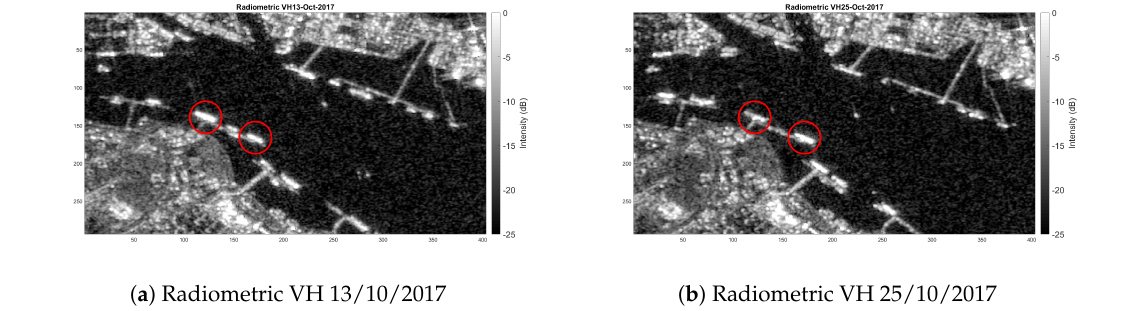
Figure 17. Consecutive radiometric images for VH polarisation: ( a ) Radiometric VH 13 October 2017,